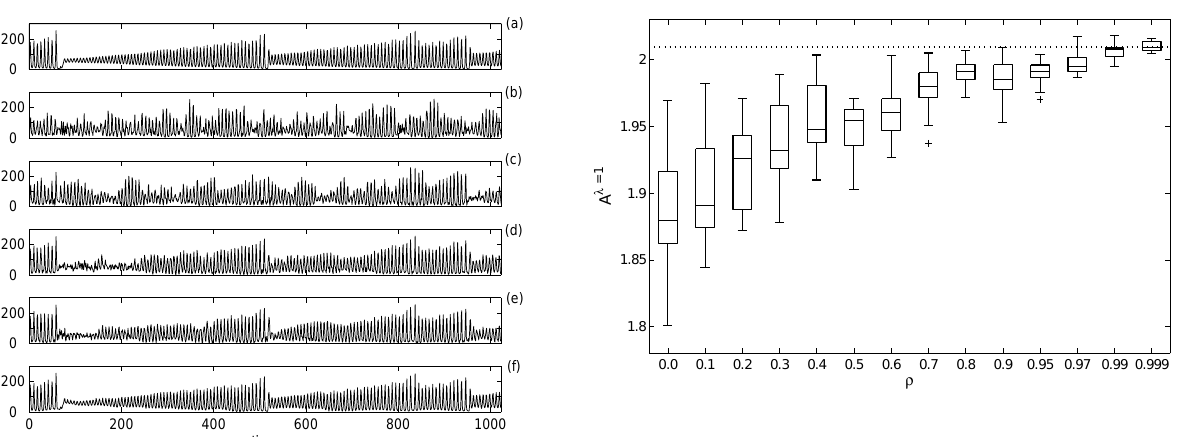
Fig. 5. Gradual wavelet reconstruction of the laser intensity data based on the one step time asymmetry, A λ = 1 . The dotted line gives the value for A λ = 1 . The boxplots are the values for the 19 surro- L gates, where the box indicates the upper and lower quartiles, the central line is the median and the whiskers extend up to 1.5 times the interquartile range, with outliers indicated by a +. Note the non- linear scale on the